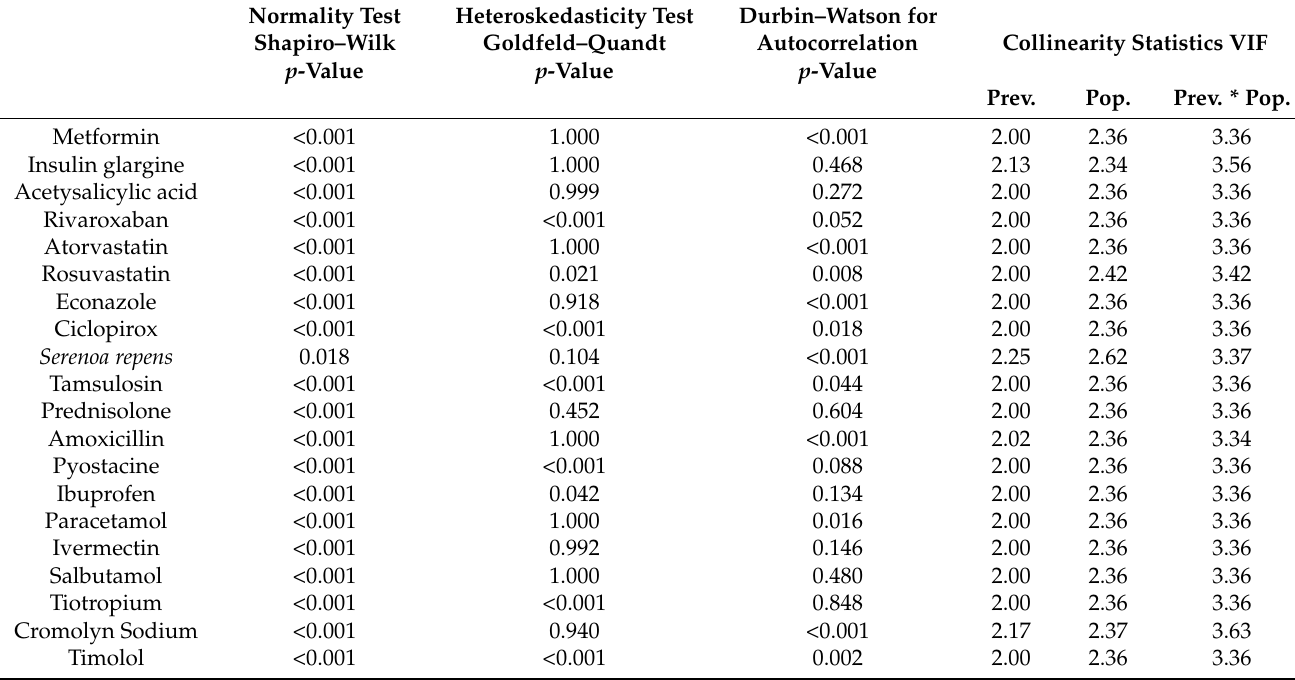
Table A1. Results of assumption verifications computed prior to linear regression